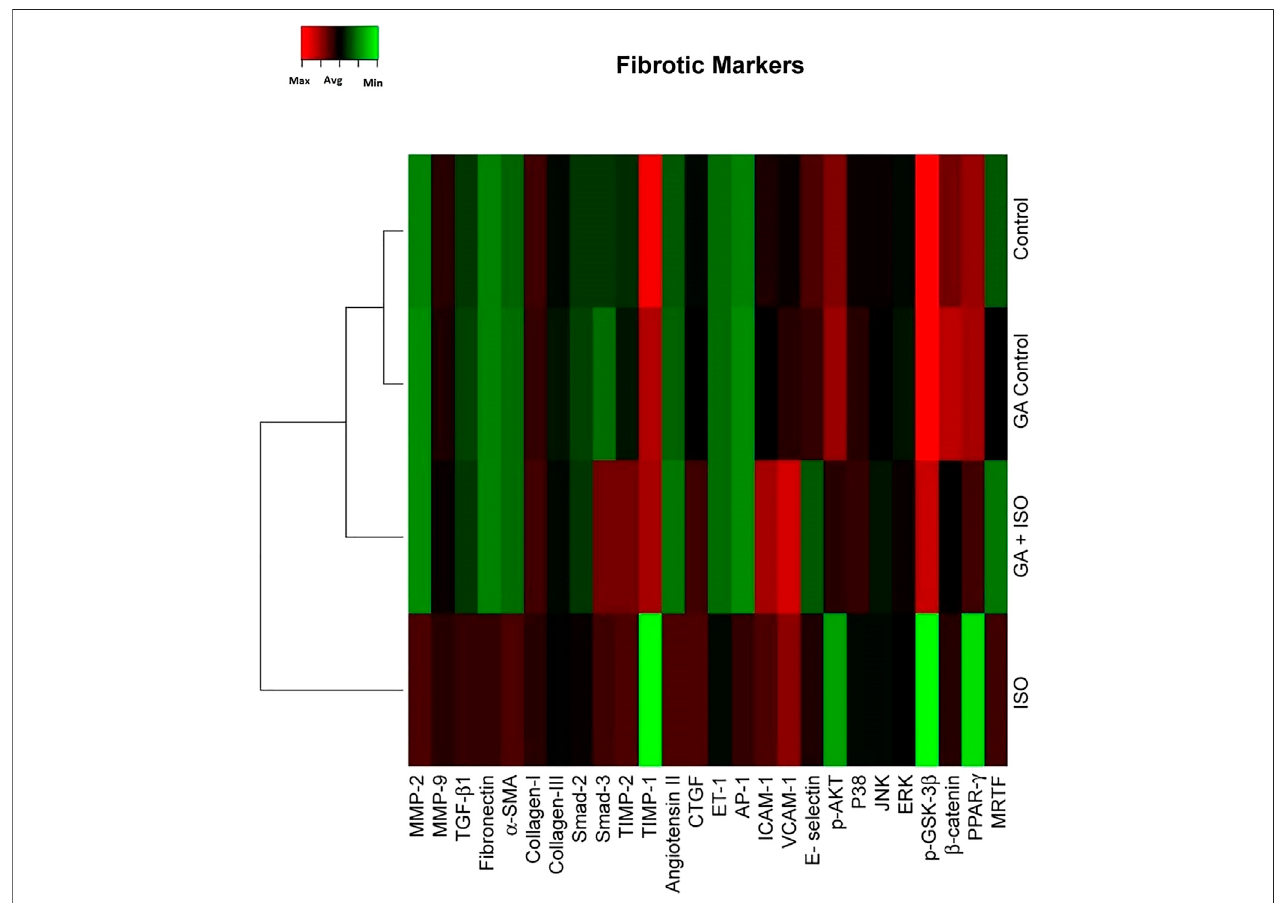
FIGURE 4 | Effect of GA on ISO-induced fi brotic gene expression pro fi le in heart tissue. Hierarchical clustergram analysis of PCR array results for fi brotic gene expression in GA and ISO-induced rats. Bright red indicates the highest normalized signal values, bright green represents the lowest signal values and black represents median signal values. The total mRNA was isolated from heart tissues and were detected using custom PCR array following the manufacturer ’ s instructions. The clustergram results of three independent experiments were analyzed using the SA Biosciences online tool. Matrix metalloproteinases MMP-2, -9 (MMP-2, -9), Transforming growth factor-beta1 (TGF- β 1), Fibronectin, Alpha-smooth muscle actin ( α -SMA), Collagen-I, Collagen-III, Smad-2, Smad-3, Tissue inhibitor of metalloproteinases-2, -1 (TIMP-2, TIMP-1), Angiotension II receptor, Connective tissue growth factor (CTGF), Endothelin-1 (ET-1), Activated protein (AP-1), intercellular cell adhesion molecule-1 (ICAM-1), vascular cell adhesion molecule-1 (VCAM-I), E-selectin, p-AKT, p38, c-Jun-N-terminal kinase (JNK), extracellular regulated kinase (ERK),Glycogen synthase kinase 3 ( p-GSK-3 β ), ß -catenin, Peroxisome proliferators-activated receptor- ? (PPAR- γ ) and myocardin-related transcription factor (MRTF).